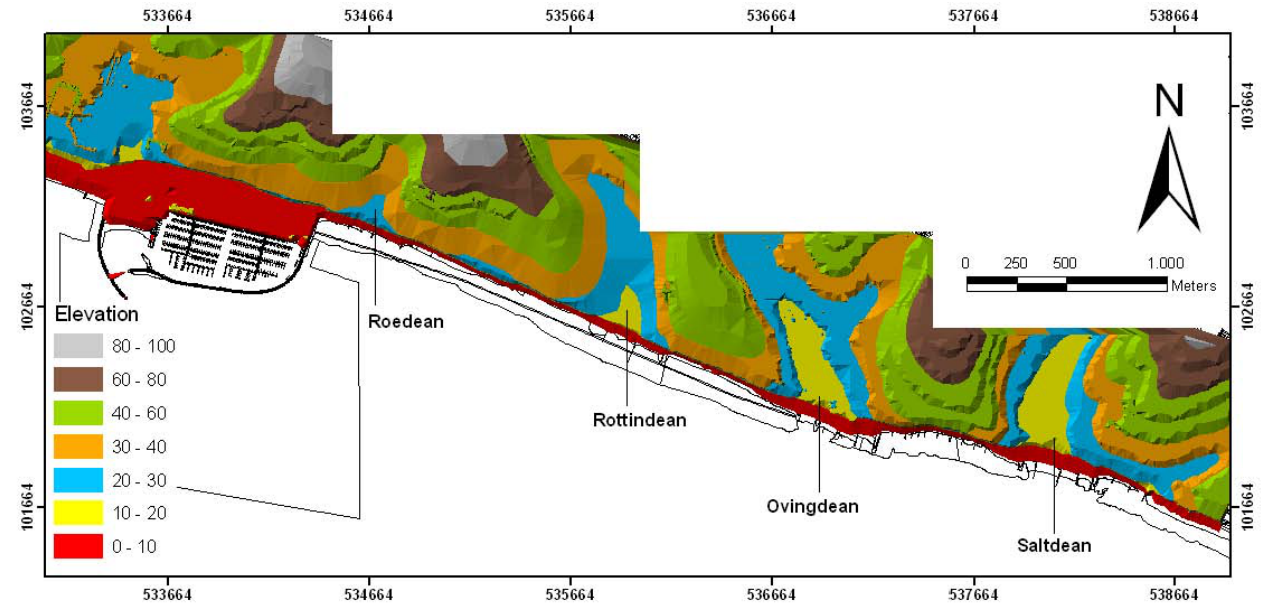
Fig. 2. Elevation map of the study area shows the impact of the dry valleys on the local morphology.